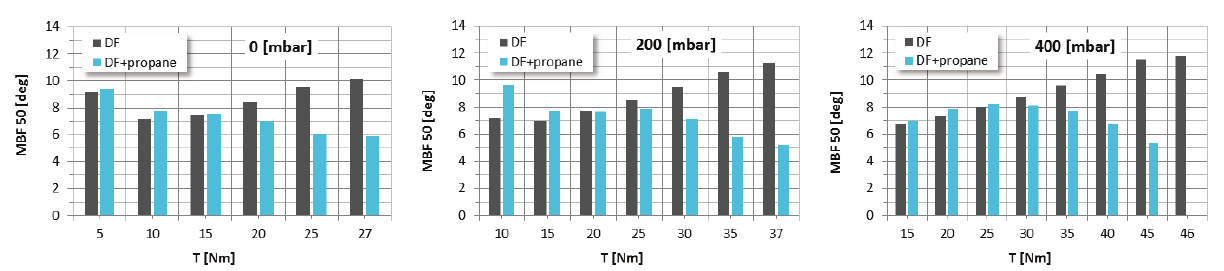
Fig. 10. Load characteristics of crank angle position at burning-out 50% of the fuel charge for both investigated engine operating modes